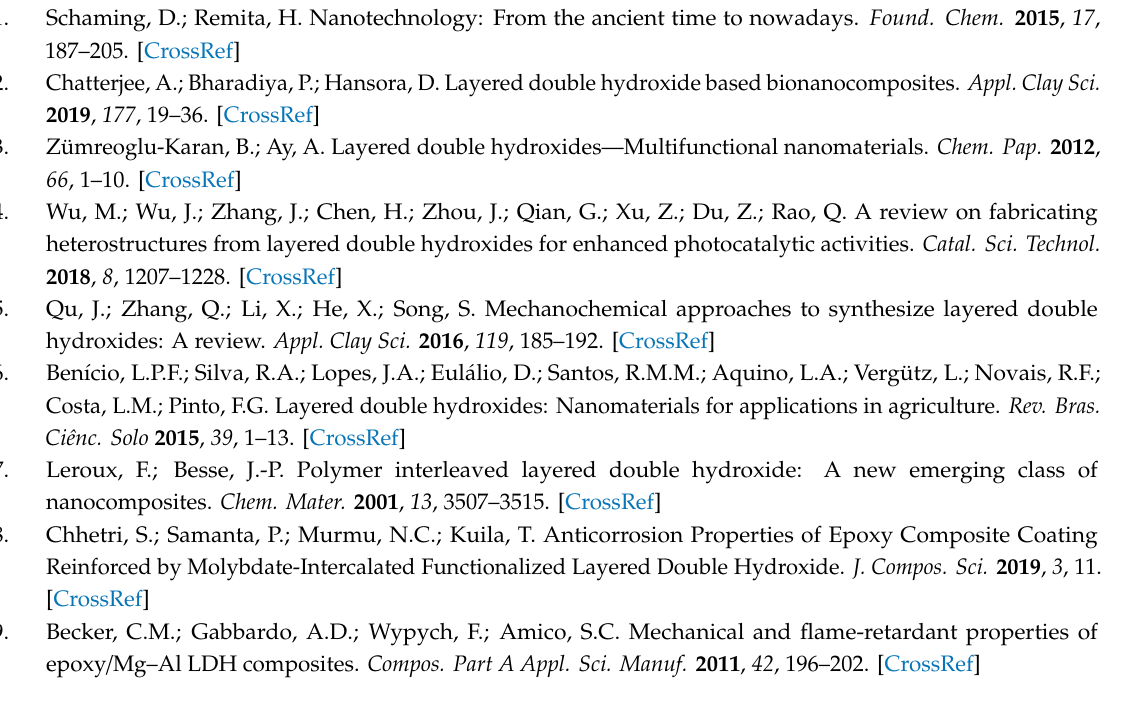
Figure A7. Plots of Value II calculated for the prepared samples under a heating rate of 2 °C ∙ min − 1 .